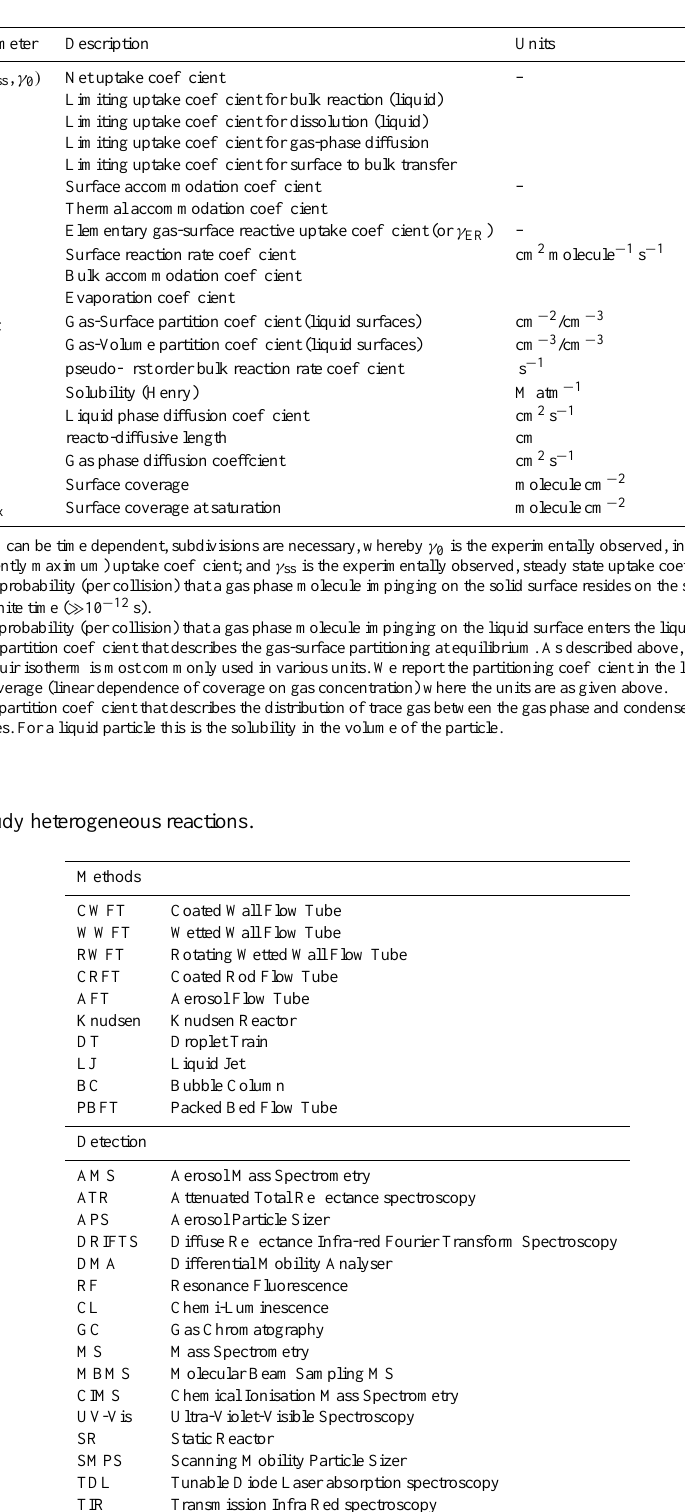
Table 1. Parameters used to describe heterogeneous reactions.